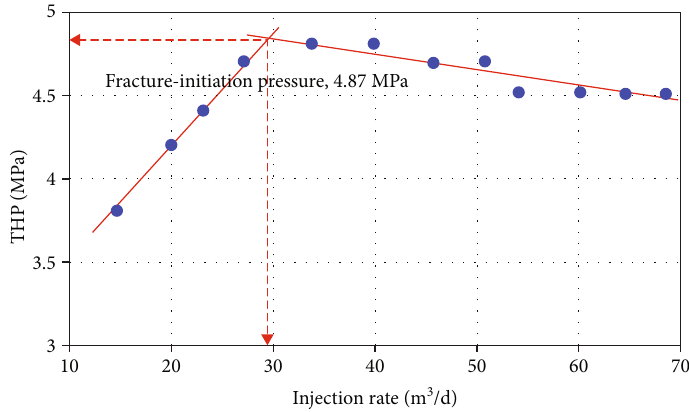
Figure 2: Step rate test of water injection well L34-30